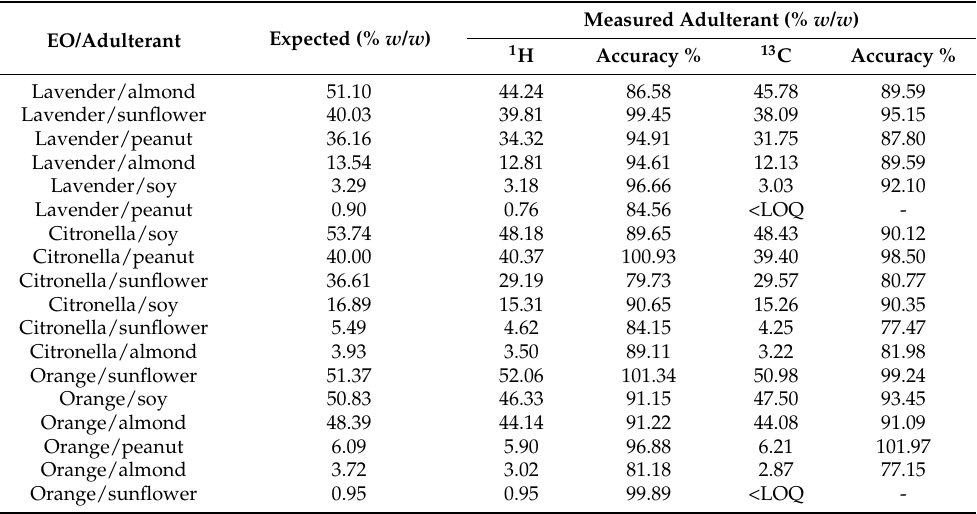
Table 4. Quantitative results expressed as adulterant percentage ( w/w ) and deviation from the real content of adulterant